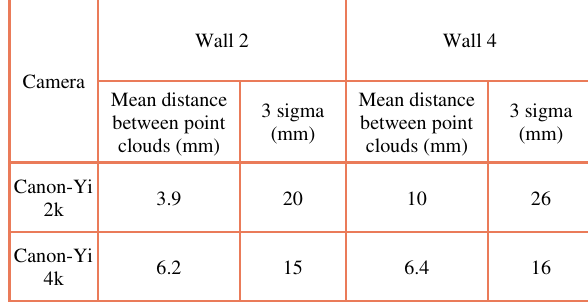
Table 3. Statistics of deviations between point clouds